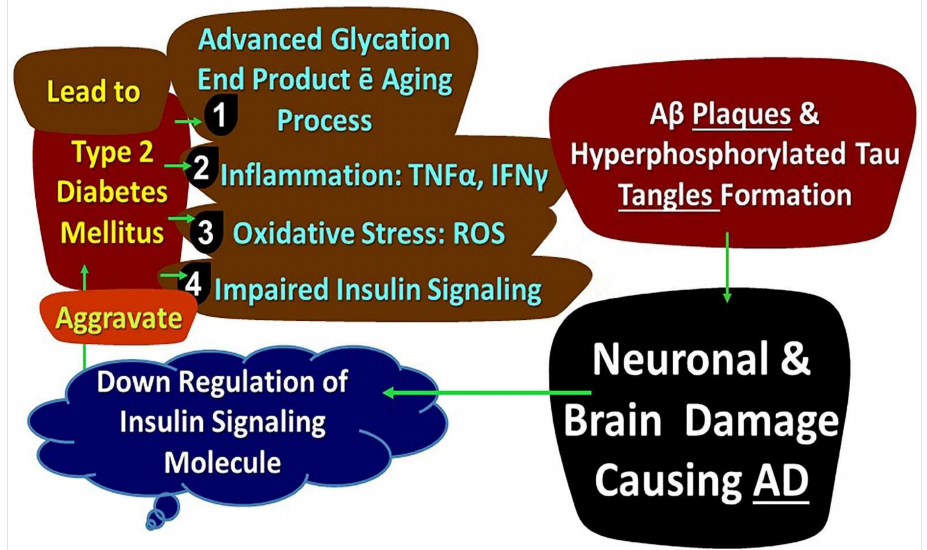
Figure 4. Illustrating Link between DM and Alzheimer’s Disease. Notes: AD: Alzheimer’s Disease, A β : Amyloid β